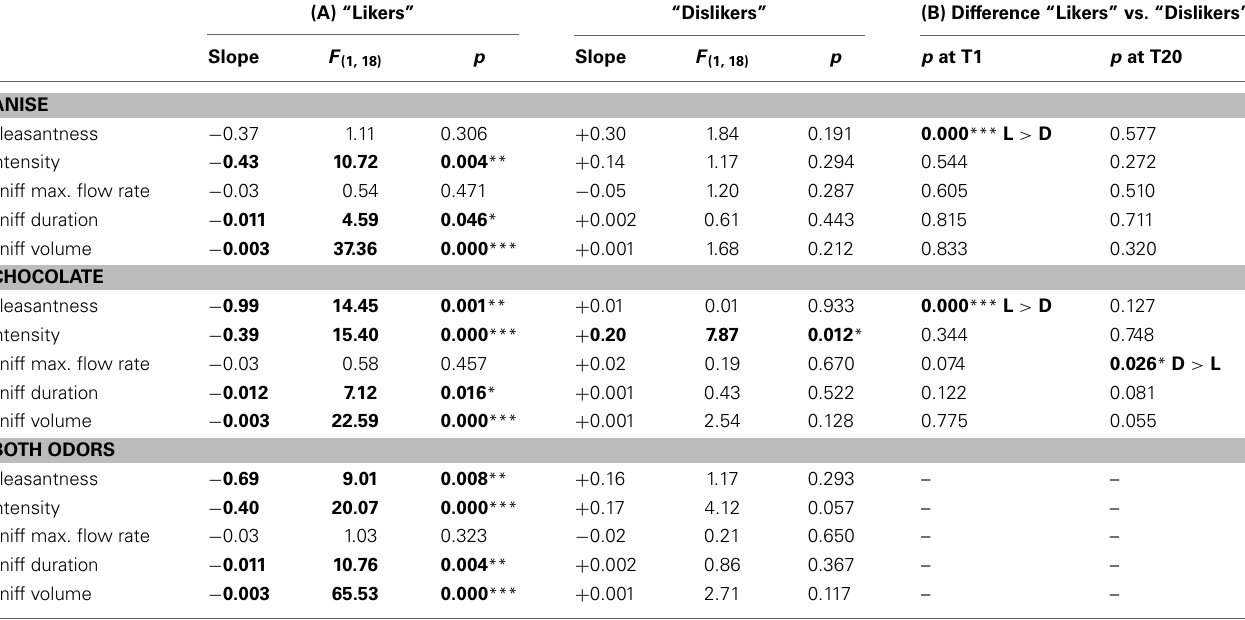
Table 1 | (A) Linear regressions between pleasantness, intensity, sniff maximum flow rate, sniff duration, sniff volume, and trial number (1 to 20) for “likers” and “dislikers” separately, and for the odors of anise and chocolate separately and together. (B) t -tests for independent samples between “likers” (L) and “dislikers” (D) at trial 1 and trial 20. (A) “Likers” (B) Difference “Likers” vs.